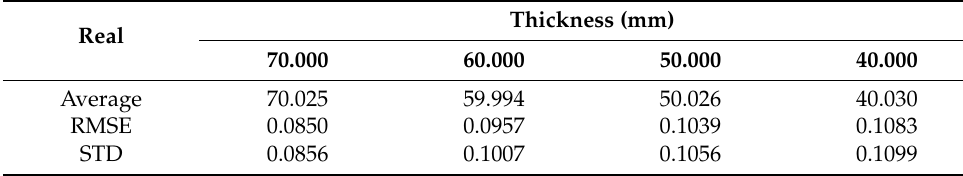
Table 2. Comparison of the measured value with the actual value.